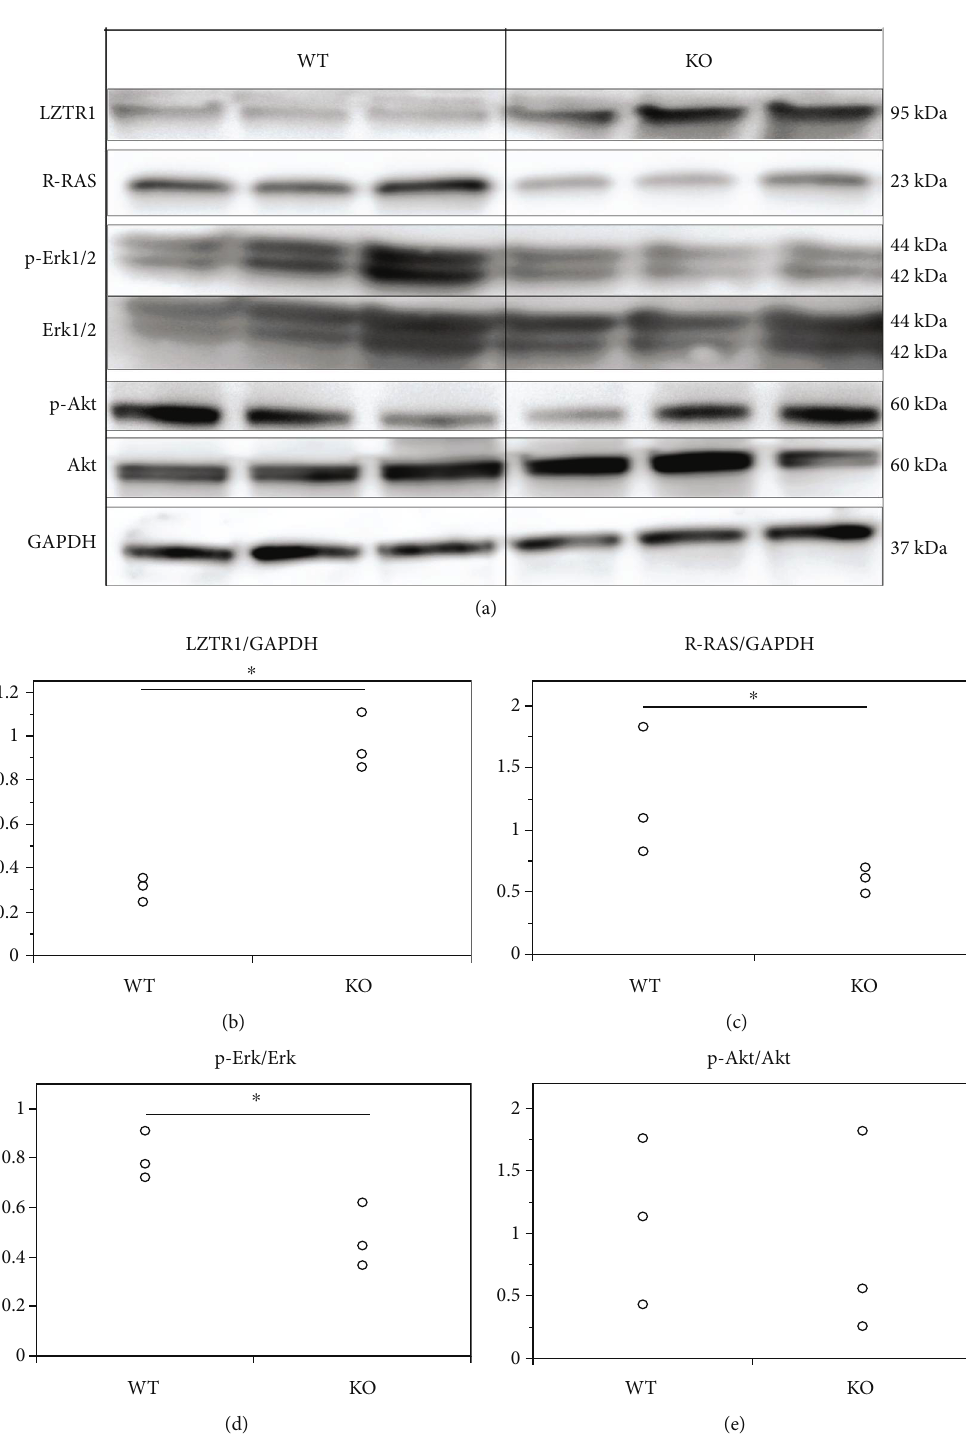
Figure 11: Expression of LZTR1 and its downstream signaling factors. Wild-type (WT) and miR-23-27-24 cluster knockout (KO), n = 3 per genotype. (a) Representative western blots of LZTR1, R-RAS, Erk1/2, phospho-Erk1/2 (p-Erk1/2), Akt, phospho-Akt1/2 (p-Akt), and GAPDH. (b) The expression of LZTR1 was signi fi cantly higher in KO mice than in WT mice, ∗ p < 0 : 05 . (c) The expression of R-RAS was signi fi cantly lower in KO mice than in WT mice, ∗ p < 0 : 05 . (d) The ratio of p-Erk1/2 expression to Erk1/2 expression was signi fi cantly lower in KO mice than in WT mice, ∗ p < 0 : 05 . (e) The ratio of p-Akt expression to Akt expression was not signi fi cantly di ff erent between KO and WT